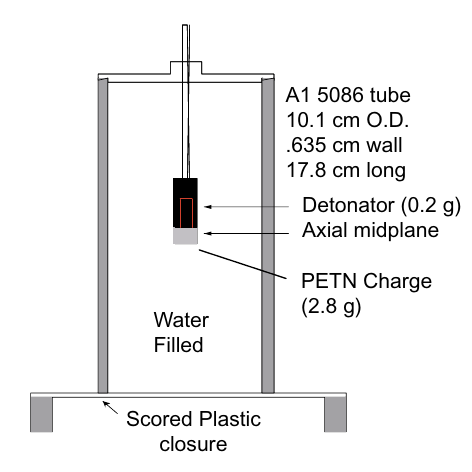
Fig. 1. Experimental